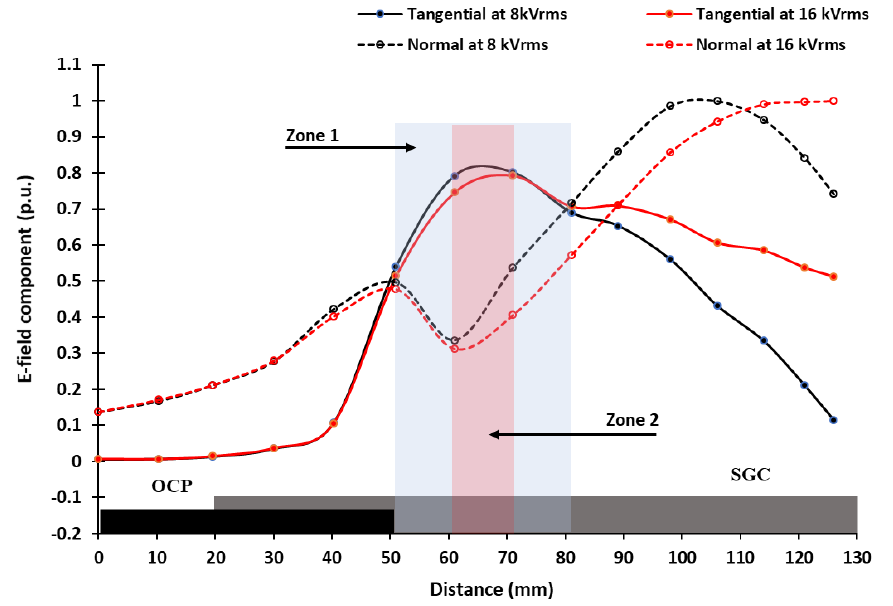
Figure 12. Comparison of the normalized E n (absolute value) and normalized E t (in p.u.) obtained at the central line on the surface of the stress grading system for applied voltages of 8 kV rms and 16 kV rms .